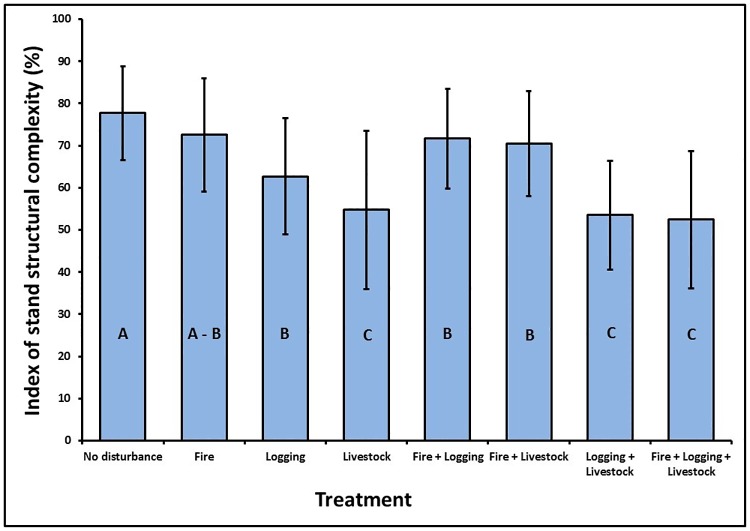
Relationship between the mean values of the index of stand structural complexity along a disturbance gradient.Bars with different letters were significantly different according to a multiple comparison post hoc test. Small bars are ± standard deviation.